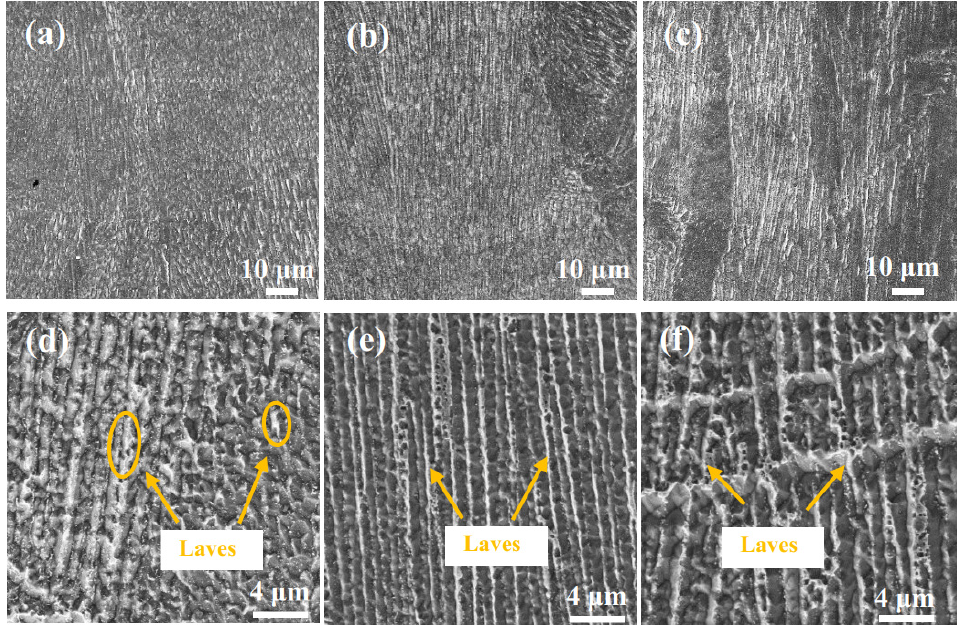
Figure 9. ( a – c ) SEM images at bottom to top with low magnification, in which the white regions represent Laves phase to show their approximate area fraction. ( d – f ) Magnified images of the three specimens.